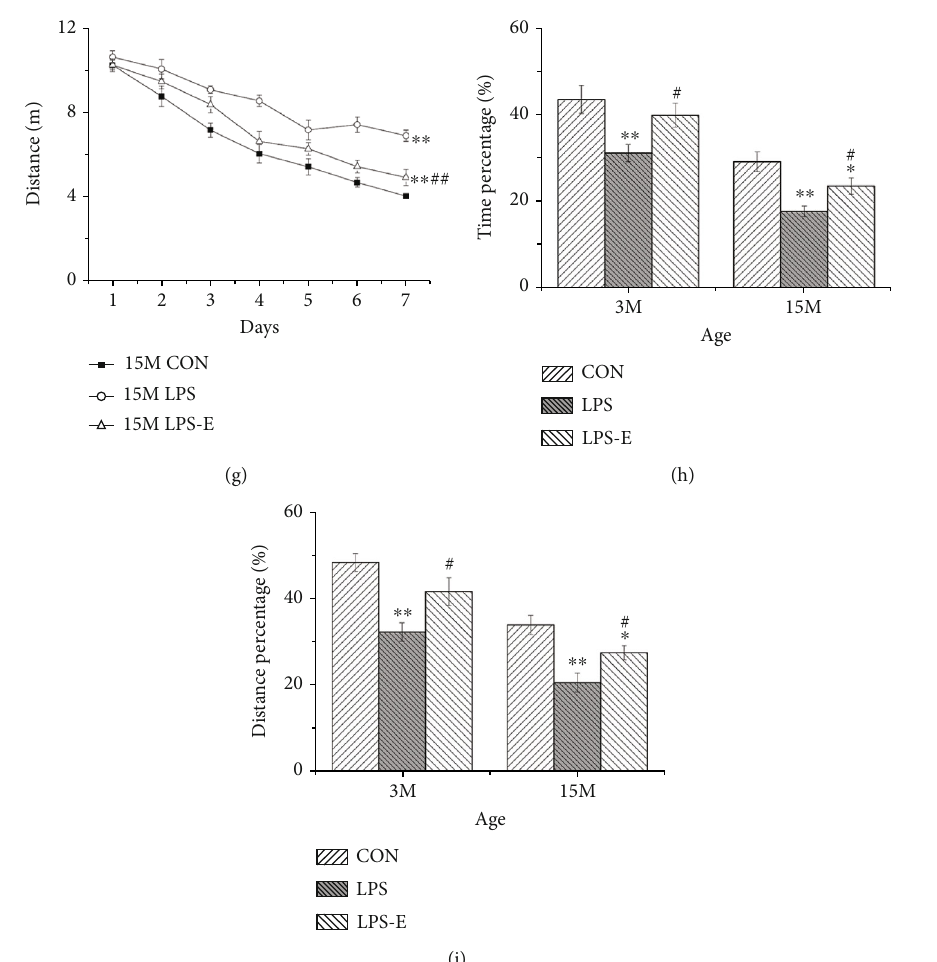
Figure 2: Learning and memory performance of in CD-1 mice in the MWM test. Latency (a), distance (b), and velocity (c) swam during the learning phase at di ff erent ages in the control groups. (d, e) Latency and distance during the learning phase by 3-month-old (3 M) and (f, g) 15-month-old (15 M) CD-1 mice in di ff erent treatment groups. The percent time (h) and distance (i) swam in the target quadrant in di ff erent treatment groups by 3 M and 15M CD-1 mice. n = 10 per group. Error bars = SEM . ∗ P < 0 : 05 , ∗∗ P < 0 : 01 compared with the control group; # P < 0 : 05 , ## P < 0 : 01 compared with the LPS group. CON: untreated control group; LPS: lipopolysaccharide treatment group; E: group of mice exposed to EE; MWM: Morris water